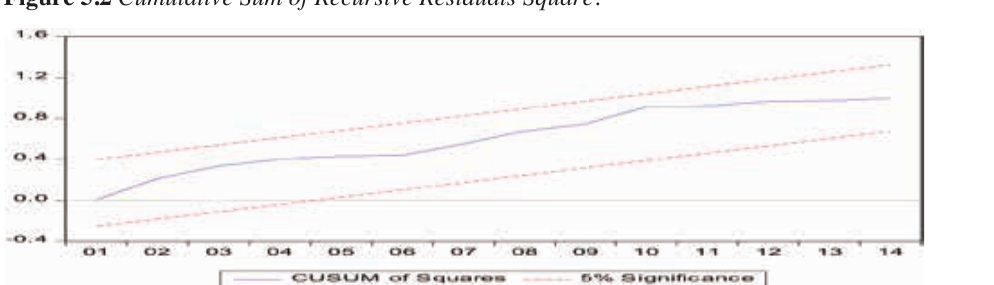
Figure 5.2 Cumulative Sum of Recursive Residuals